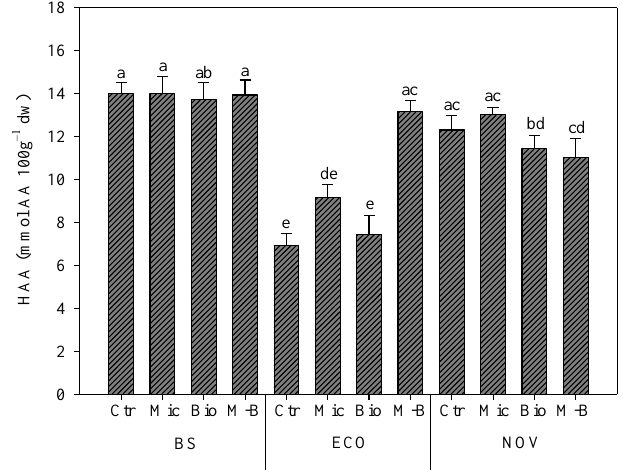
Figure 6. Hydrophilic antioxidant activity (HAA) in tomato fruits as affected by the interaction mulching (ECO: biodegradable film Ecovio; NOV: biodegradable film MaterBi ® ; BS: bare soil) and biostimulant application (Bio: treated with Phylgreen ® ; Mic: treated with Trianum-P ® ; M-B: combination of Bio and Mic; Control: not treated). Each column indicates the mean value of the three replicates. Vertical bars indicate standard error; different letters indicate significant differences according to Tukey’s test ( p < 0.05).